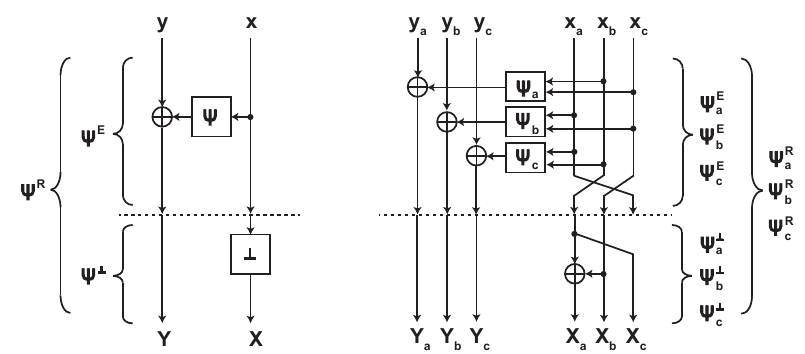
Figure 4: Extension and restriction of a mapping (left) and the corresponding sharing